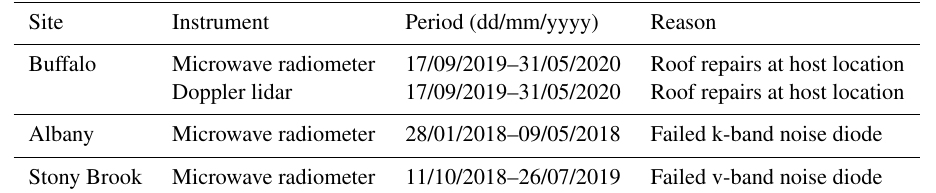
Table 3. Major data gaps from January 2018 to August 2021.